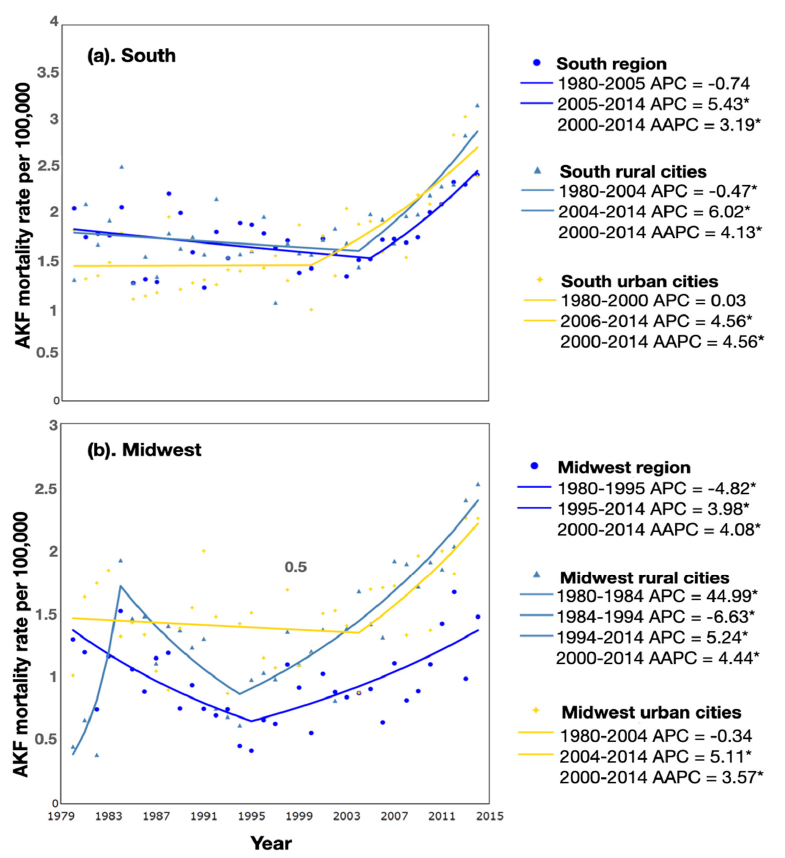
Figure 2. Mortality trends for acute kidney failure by tertiles of pesticide consumption, 1980–2014. ( a ) Acute kidney failure mortality rates for south rural municipalities. ( b ) Acute kidney failure mortality crude rates for midwest rural municipalities. * Significant at p < 0.05.